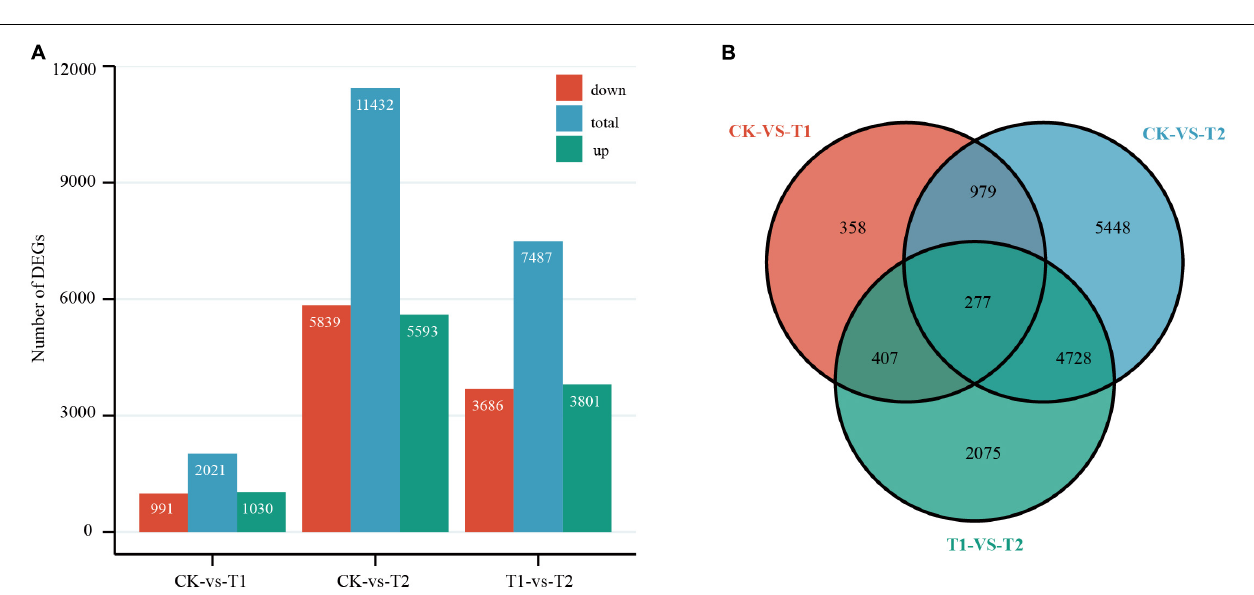
FIGURE 3 | Differentially expressed genes (DEGs) in Heimia myrtifolia during drought stress. (A) The number of DEGs between CK and drought treatment group in T1 and T2. (B) Venn diagram representing DEGs expressed after drought treatment.